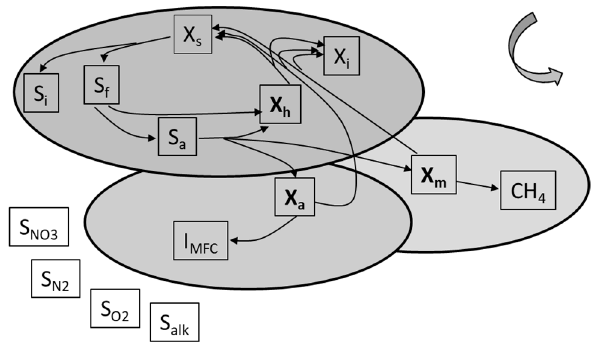
Figure 2. Schematics of the interaction between exoelectrogems (X a ), methanogens (X m ) and heterotrophs (X h ) populations in a MFC as represented in the modified integrated model. The reactions outside the shaded areas (unconnected) are not represented in the model.